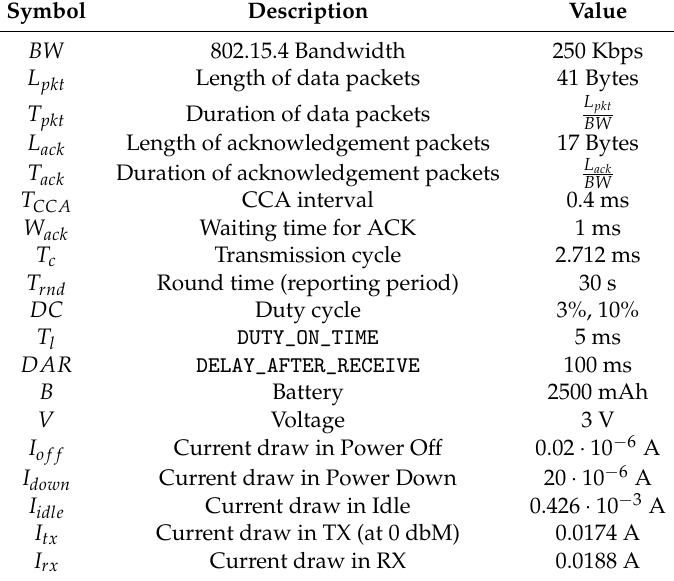
Table 3. Parameters used in the validation of the analytical model.